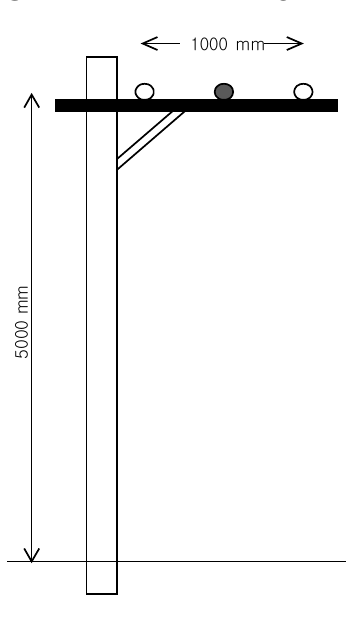
Figure 4. O/H line